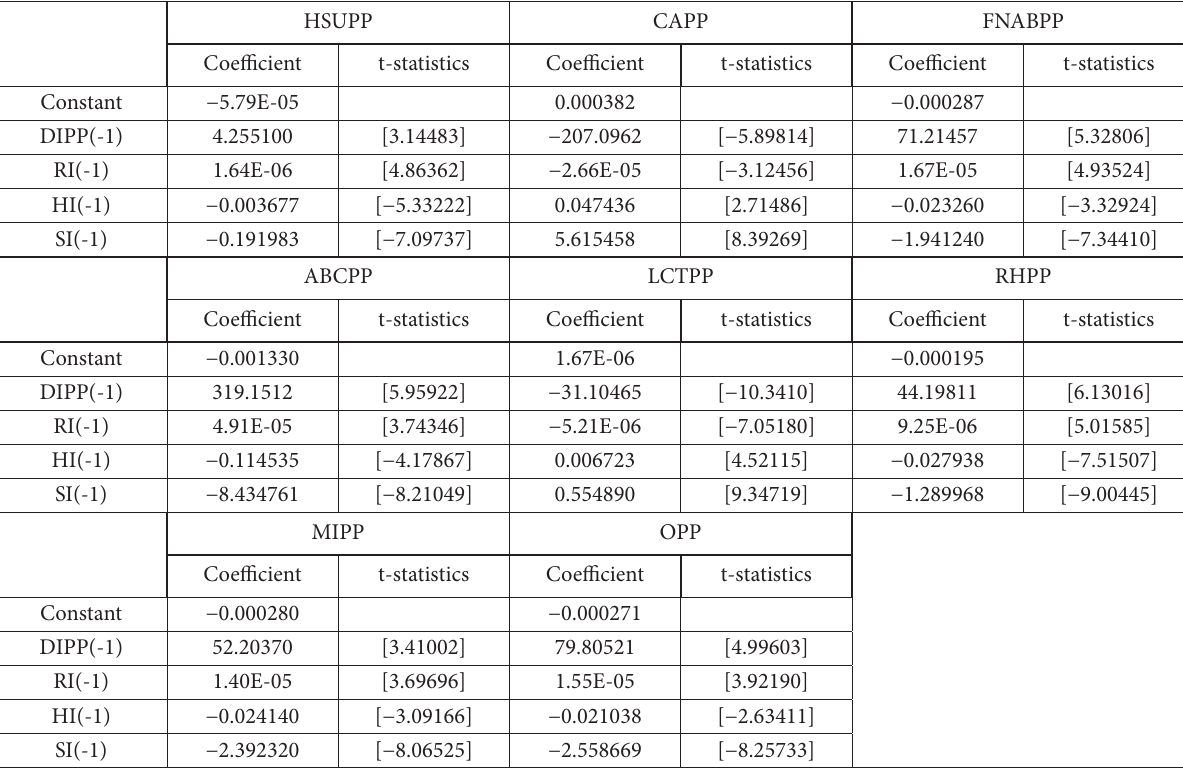
Table 11. Vector error correction model for sub-categories of non-durable goods consumption (long-term equilibrium relationship) HSUPP